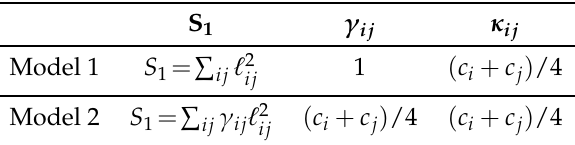
Table 1. The Gaussian bond potential S 1 and the parameters γ ij and κ ij assumed in Model 1 and Model 2. (see Equation (A9) in Appendix A.1)